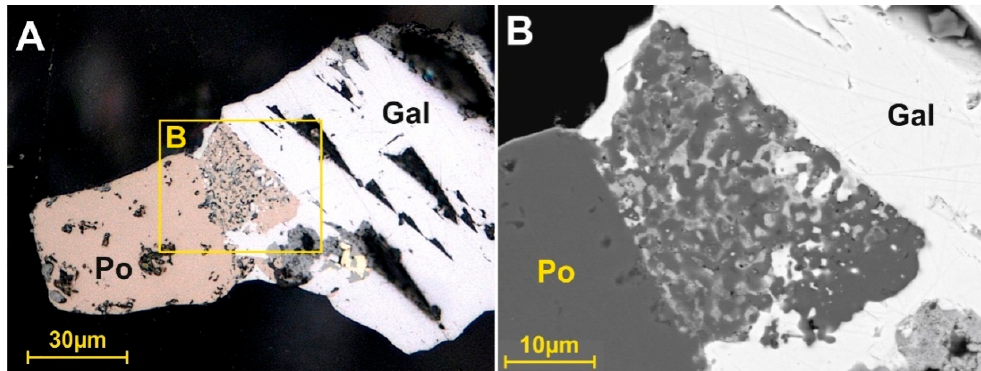
Figure 15. ( A ) aggregate of pyrrhotite (Po), galena (Gal), argentotetrahedrite (gray), and chalcopyrite (yellow) in galena, polished section photo under plane polarized light; ( B ) BEI of the aggregate.